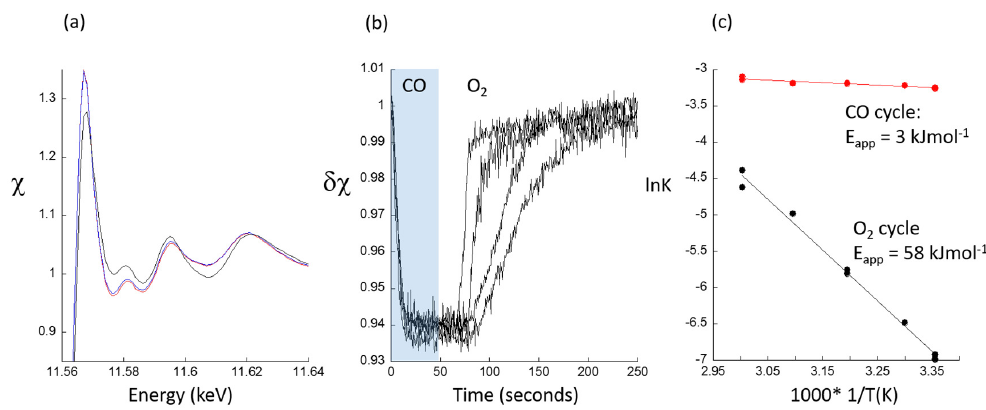
Figure 20. ( a ) Close up view of the Pt L 3 -edge XANES obtained at a rate of 4 Hz per spectrum during periodic redox operation over the T-94 catalyst at room temperature. ( b ) Temporal changes in integrated white line intensity on the Pt L 3 -edge XANES during single redox (CO/O 2 ) cycles carried out at temperatures between 298 and 333 K. ( c ) Arrhenius plots derived from the time resolved XANES for the redox events observed to be occurring in the Pt XANES that may be directly correlated to CO 2 production in the CO cycle (red) and O 2 cycles (black). Reproduced from Nat. Comms. 2015 , 6 ,